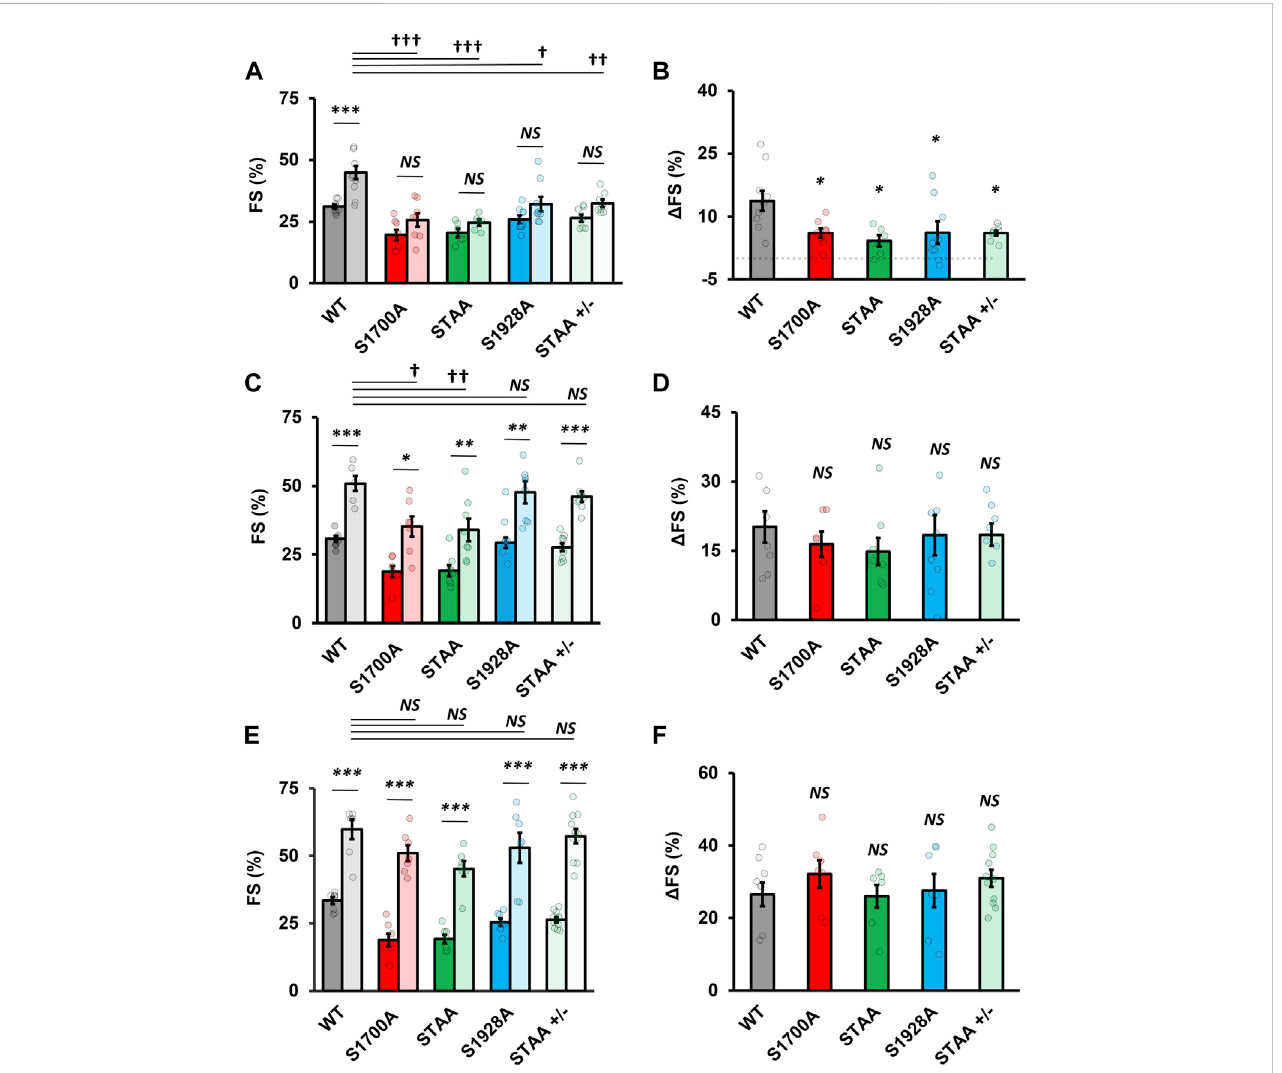
FIGURE 3 Impaired inotropic response to physiologic range β -adrenergic stimulation in mice with Ca V 1.2 phosphoregulatory site mutations. (A) Fractional shortening and (B) change in fractional shortening in WT, S1700A, STAA, and S1928A, and STAA heterozygous (+/ − ) mice before and after 0.25 μ g/kg intraperitoneal isoproterenol administration. (C) Fractional shortening and (D) change in fractional shortening intraperitoneal before and after 1 μ g/kg drug administration. (E) Fractionalshorteningand (F) changeinfractionalshorteningintraperitonealbeforeandafter100 μ g/kgdrugadministration.Statistical signi fi cance determined via ANOVA with Tukey post-hoc tests. Error bars are S.E.M.; N 0.25 μ g/kg = 11, 8, 6, 8, 8 (for WT, S1700A, STAA, S1928A, STAA +/ − , respectively);